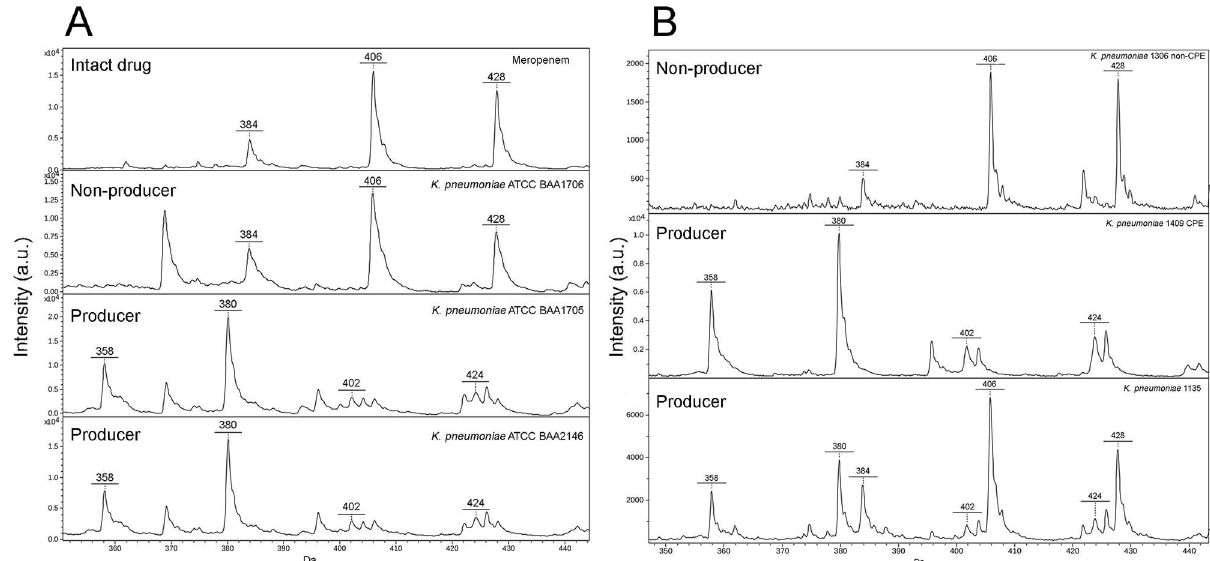
Fig 1. Spectra obtained by MHA. A) The spectrum obtainedfor the pure meropenem(arrived with ice) showedthe peaks correspondingto the intact drug (384 ± 1 Da) and to its sodium salts (406 ± 1 Da; 428 ± 1 Da); the spectrum obtained for the carbapenemase-nonproducing reference strain ( K . pneumoniae ATCC BAA-1706) showedthe same peaks as the pure meropenem, whilethe 2 carbapenemase-producing reference strains ( K . pneumoniae ATCC BAA-1705, bla KPC positive, and K . pneumoniae ATCC BAA-2146, bla NDM positive) gave the peaks correspondingto the meropenemdegradation(358 ± 1 Da, the decarboxylated product) and to its sodium salts (380 ± 1 Da; 402 ± 1 Da; 424 ± 1 Da). B) Exampleof spectra obtained for clinicalsamples tested with pure meropenemarrived with ice: a carbapenemase-nonproducing strain and two carbapenemase-producingstrains, one of which ( K . pneumoniae No. 1135 strain) showingthe peaks corresponding to both the pure meropenemand the degradationproducts of the drug.